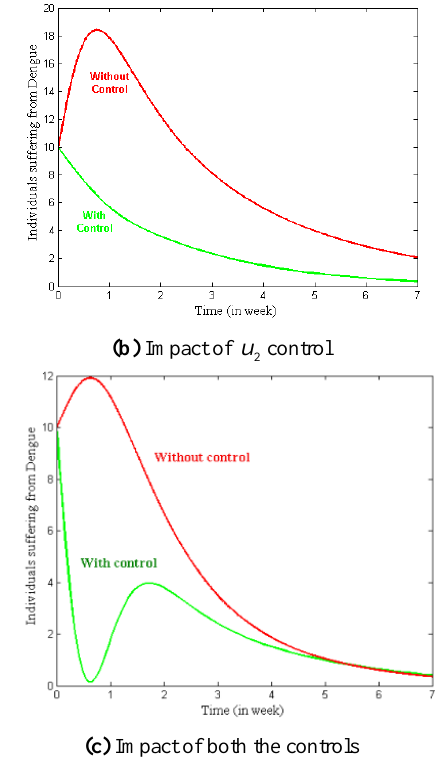
Figure 7. Impact of controls on class of dengue infected individuals